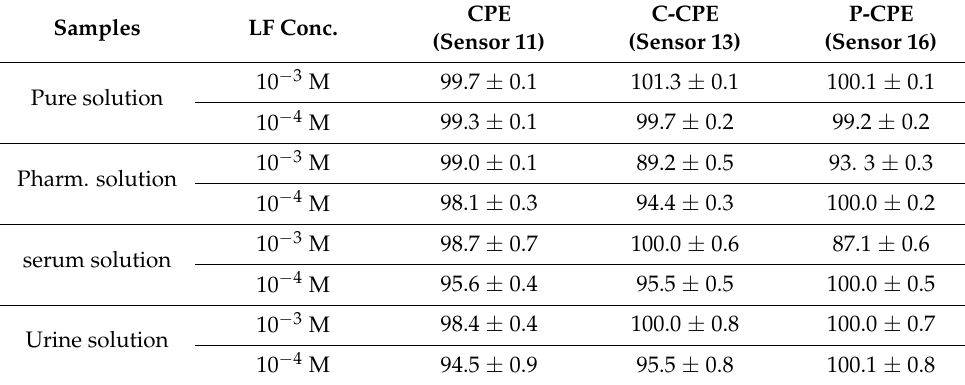
Table 6. Recovery values of the best sensors for the determination of LF using the direct potentio- metric method method at room temperature of 22 ± 2 ◦ C at pH 4.1. The electrode compositions (%, wt / wt ) are given in (Table